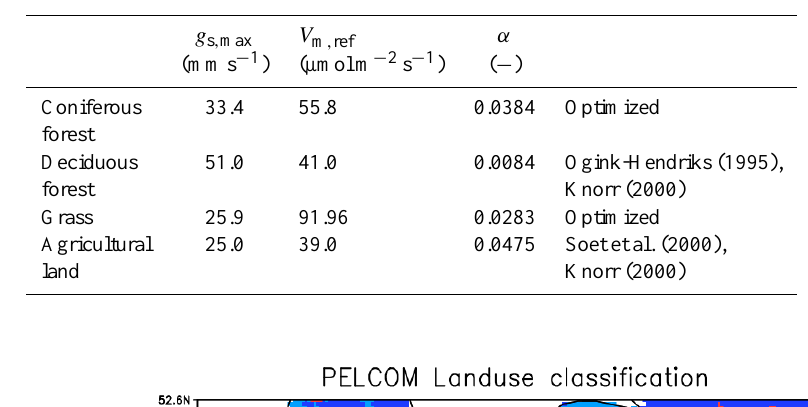
Table 2. Parameters for calculating the surface conductance and the net ecosystem exchange, classified by land use. g s , max : maximum surface conductance (mms − 1 ), V m , ref : maximum catalytic capacity for Rubisco at canopy level (µmolm − 2 s − 1 ) and α the intrinsic quantum use efficiency [ − ].